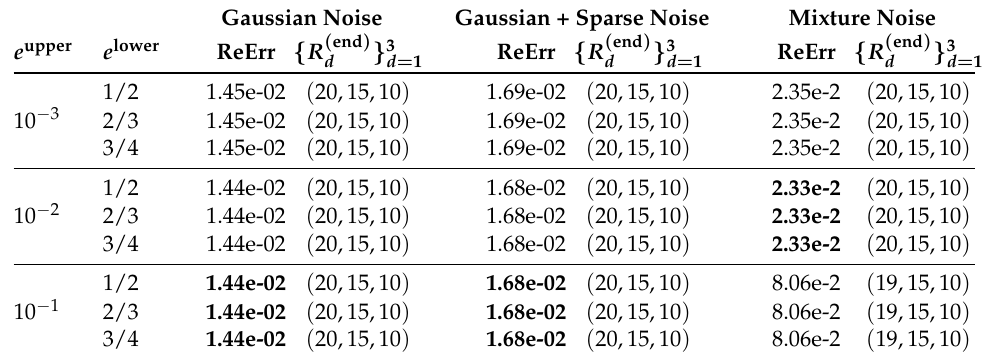
Table 5. ReErr values and estimated ranks of our method under different settings of e upper and e lower . This test is based on synthetic data denoising, and the original data are with size 50 × 50 × 50 and Tucker rank ( 20,15,10 ) . The best results are highlighted in